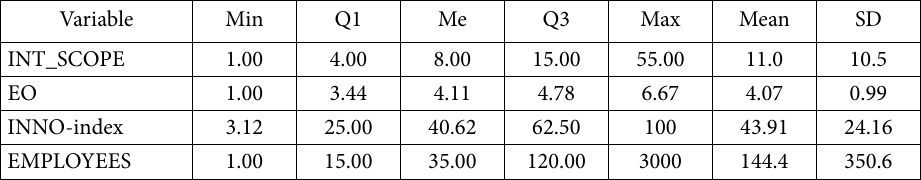
Table 2. Descriptive statistics for the applied variables (source: own calculations based on a survey ( n = 355)) Variable Min Q1 Me Q3 Max Mean SD INT_SCOPE 1.00 EO EMPLOYEES